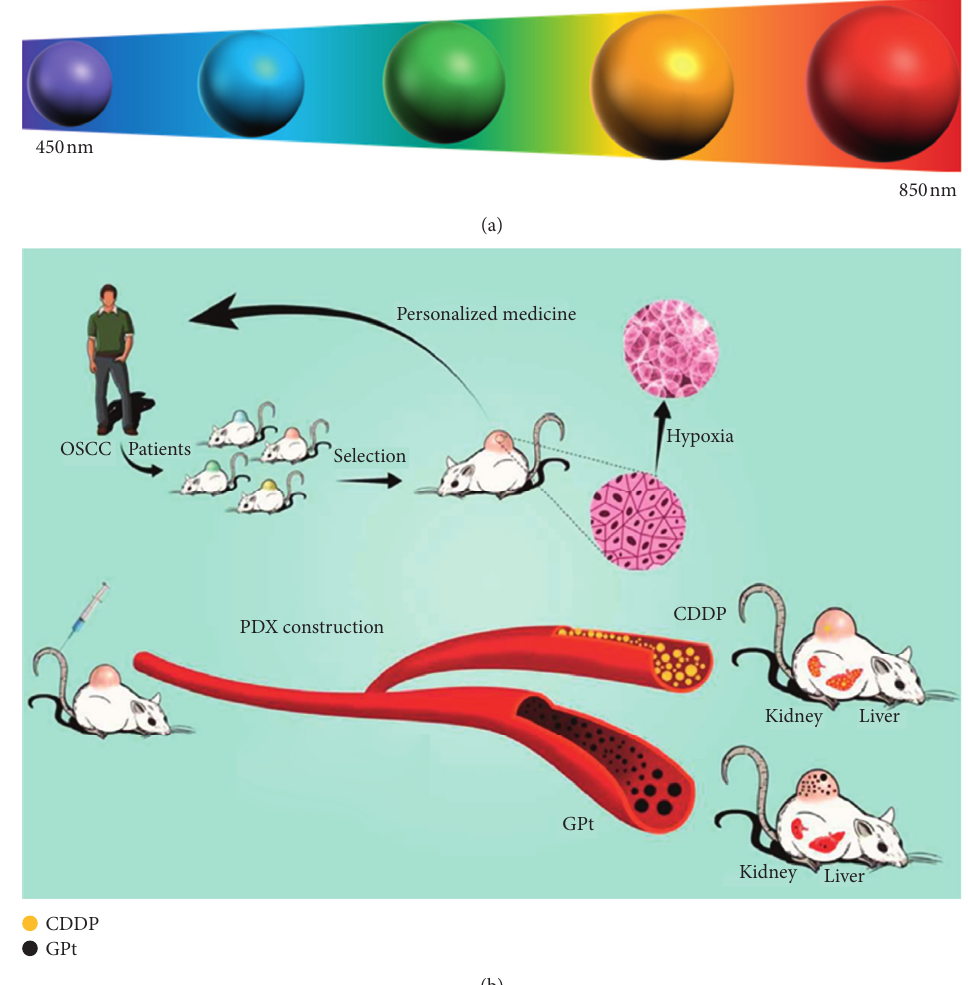
Figure 6: (a) The fluorescence emission properties of QDs can be modulated by changing their size. (b) Schematic illustration of a multifunctional anticancer platform against hypoxia-induced chemoresistance of OSCC